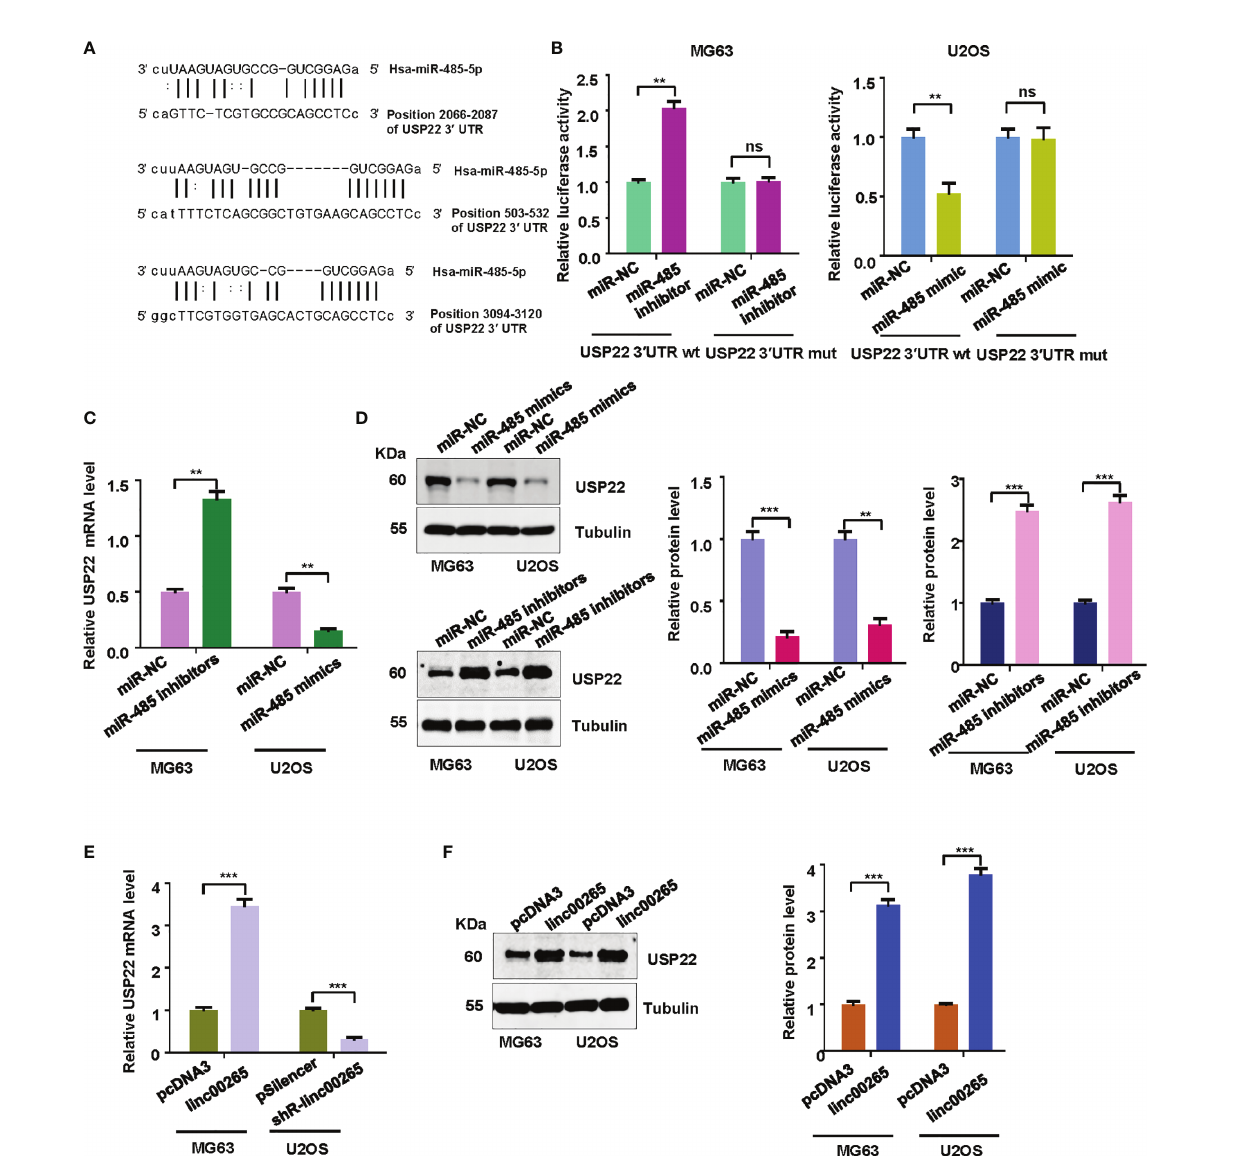
FIGURE 5 | USP22 is a downstream target of miR-485-5p. (A) The TargetScan database was utilized to predict the downstream target of miR-485-5p. USP22 3 ’ UTR has the complementary binding sites with miR-485-5p. (B) Luciferase reporter assay was used to con fi rm USP22 as a target of miR-485-5p in MG63 and U2OS cells. (C) The expression of USP22 mRNA levels was detected by qRT-PCR in MG63 and U2OS osteosarcoma cells after miR-485 changes. (D) The expression of USP22 protein levels was detected by Western blotting in osteosarcoma cells after miR-485 changes (Left panel). The quantitative data were demonstrated for USP22 protein levels (Right panel). (E) The expression of USP22 mRNA levels was detected by qRT-PCR in osteosarcoma cells after linc00265 changes. (F) The expression of USP22 protein levels was detected by Western blotting in osteosarcoma cells after linc00265 changes (Left panel). The quantitative data were demonstrated for USP22 protein levels (Right panel). ** P < 0.01, *** P < 0.001 vs. control. ns, no statistic